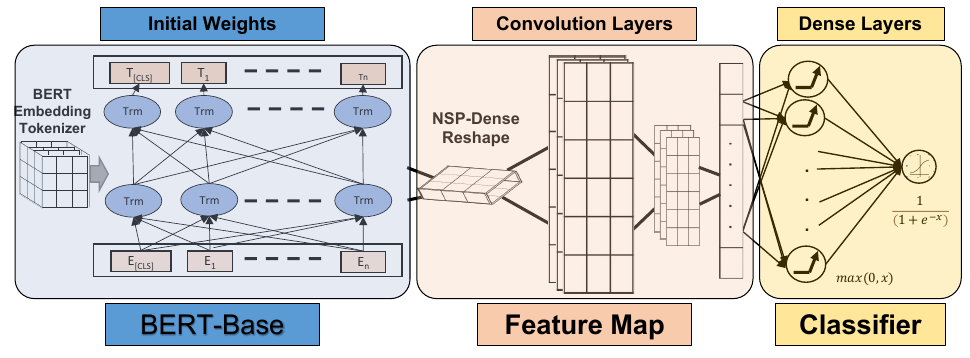
Figure 4. ClaimsBERT framework